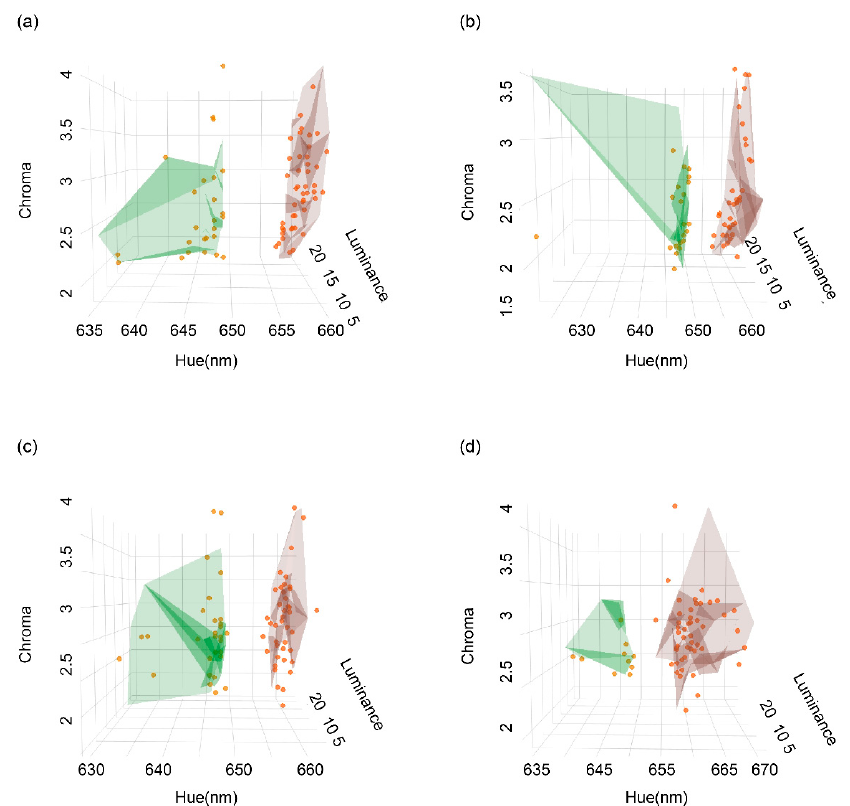
Figure 2. Results of a cluster analysis of hue, chroma and luminance by sex and body region (throat, venter). ( a ) Throat in females, ( b ) throat in males, ( c ) venter in females and ( d ) venter in males.